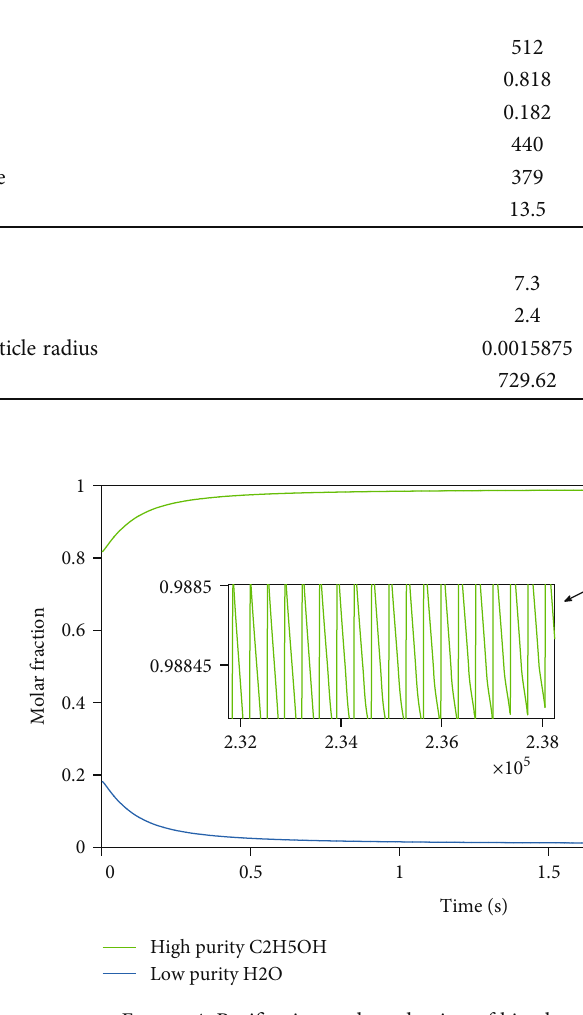
Figure 4: Puri fi cation and production of bioethanol from the start-up.